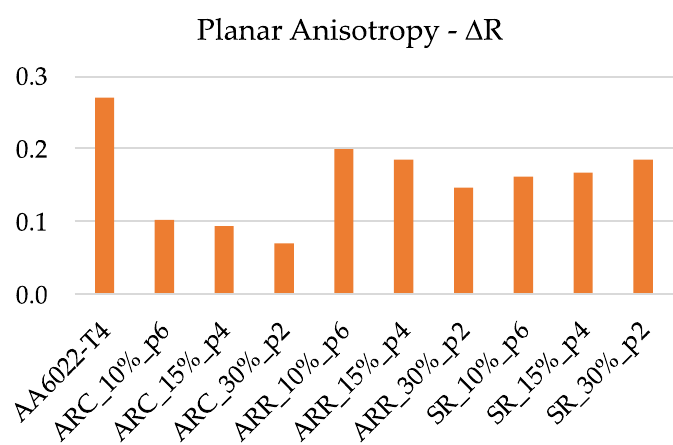
Figure 11. 𝑅(cid:3364) ‐ value evolution with the rolling conditions.